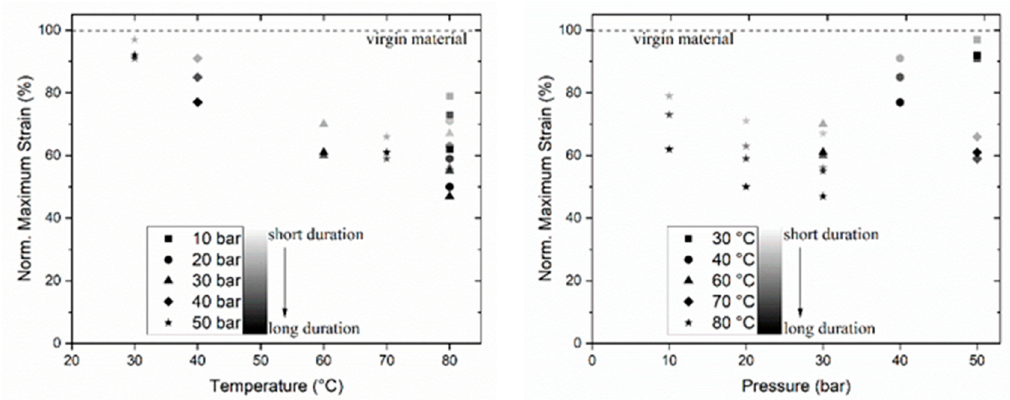
Figure 4. Retained elongation R ε measured after exposure in autoclaves as a function of temperature (left) and pressure (right). The duration of exposure is visualized by the gray scale of the symbols. Note that at 80 °C experiments at three different pressures (10, 20, and 30 bar, different symbols) were performed.